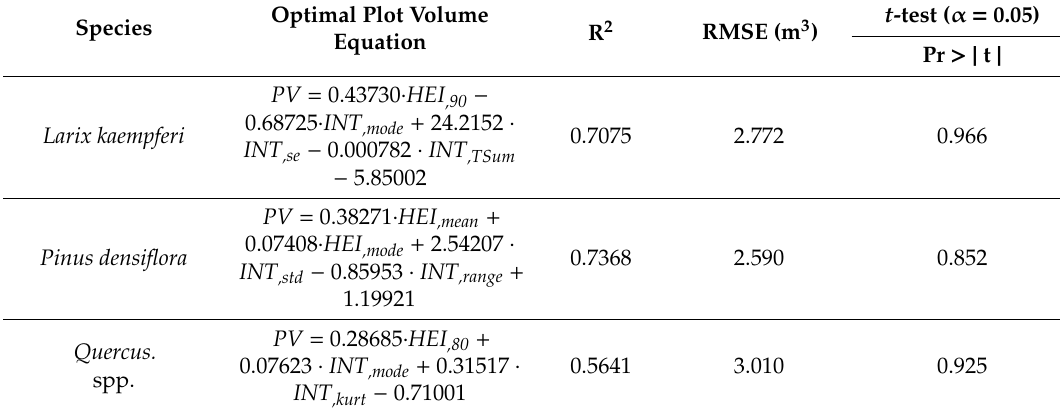
Table 6. Selected optimal regression models for each